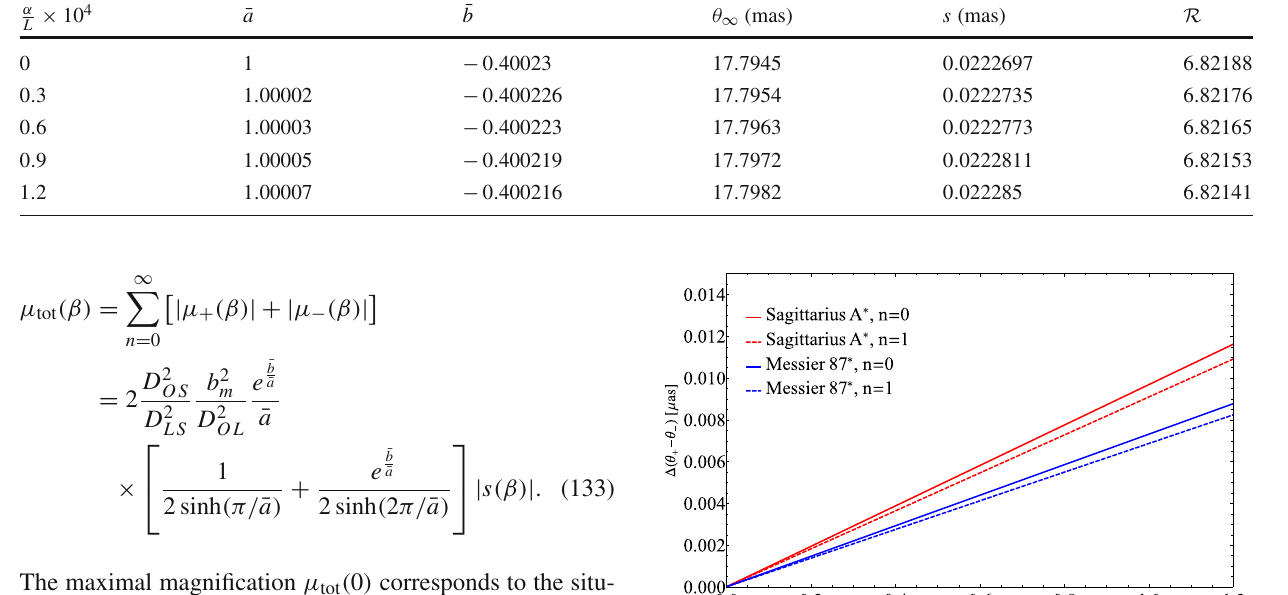
Table 5 The numerical estimation of the observables of the strong gravitational lensing for the case of Messier 87 galaxy